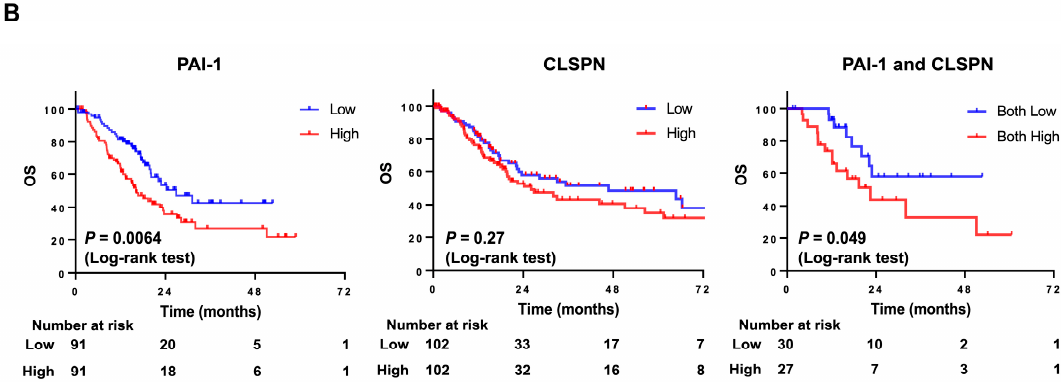
Figure 5. Kaplan–Meier survival curves for high vs. low expression of PAI1 alone, CLSPN alone, and the combination of PAI1 and CLSPN in GEO cohort (GSE87304). ( A ) RFS and ( B ) OS.